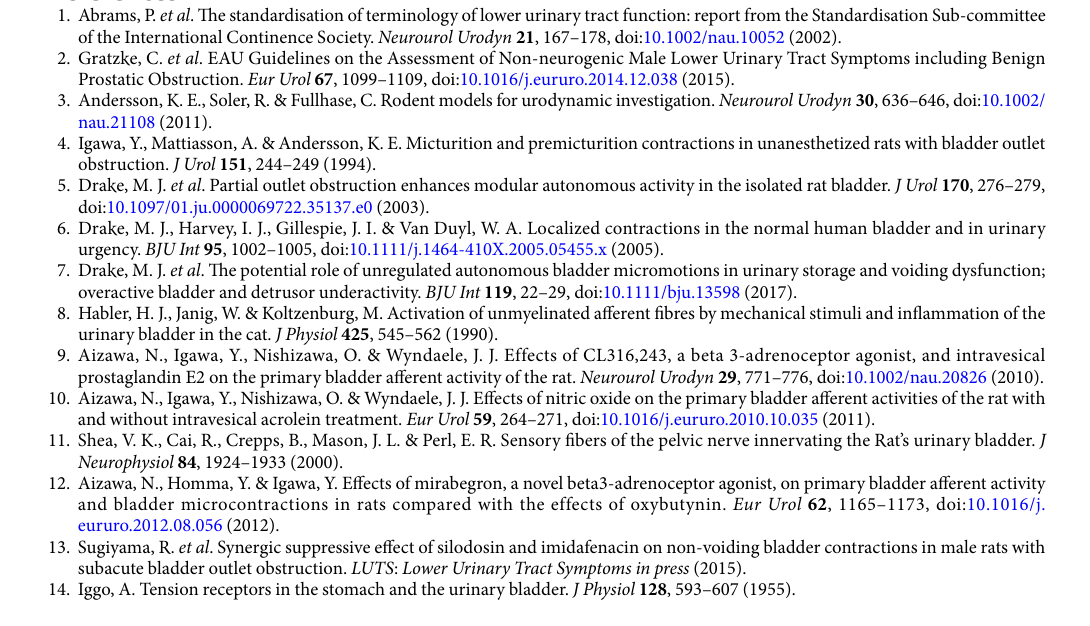
7 SCIeNTIFIC REpoRTs | 7: 7646 | DOI:10.1038/s41598-017-07898-y